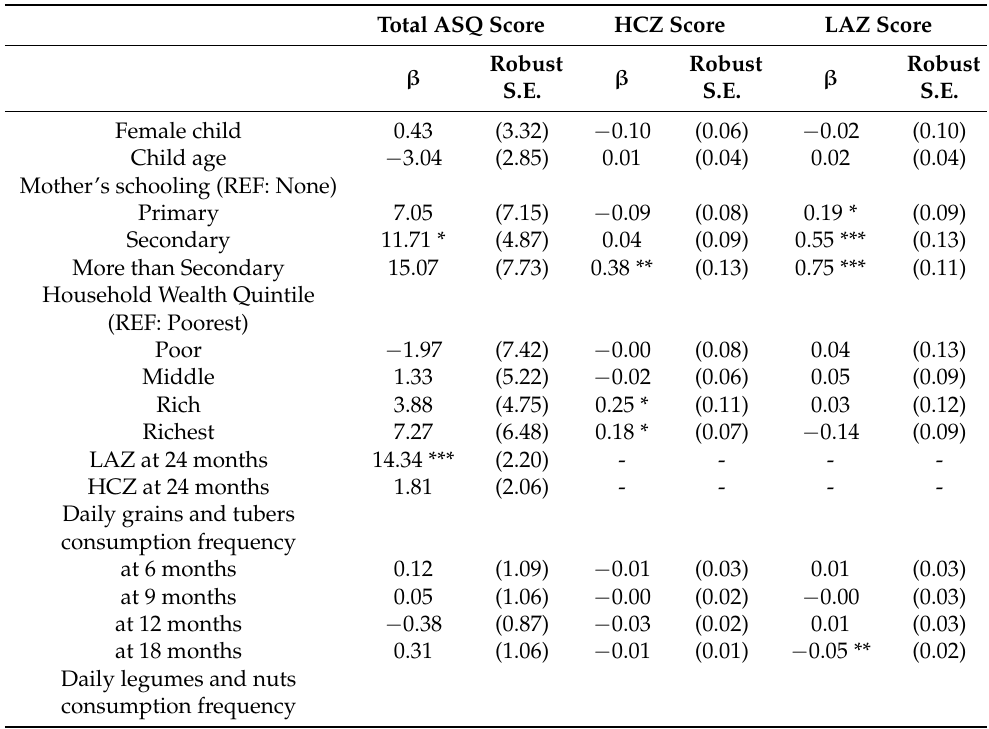
Table A3. Association between ASQ score, HCZ and LAZ, and the daily food group consump- tion